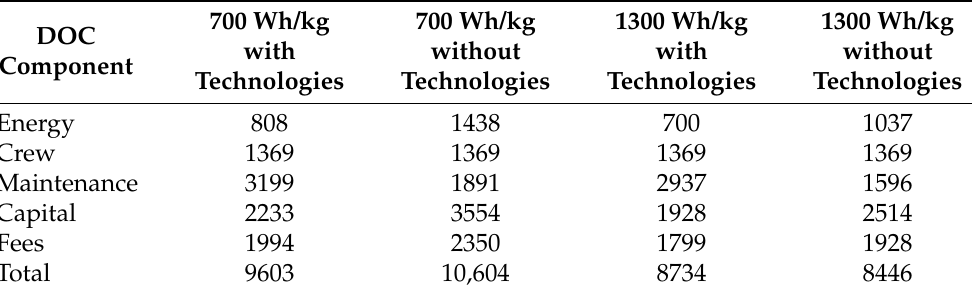
Table 9. Comparison of DOC components depending on the battery energy density for the SE 2 A SR aircraft in EUR/flight.